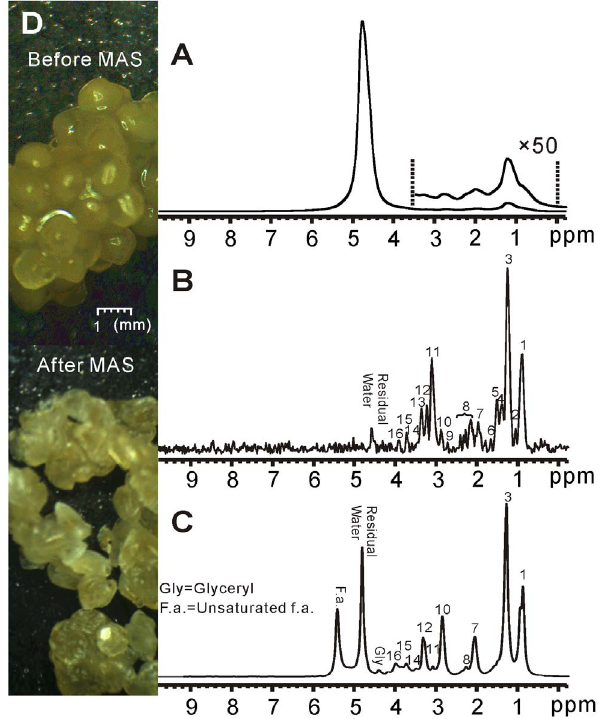
Figure 4. 1 H NMR spectra of shishamo smelt eggs. (A) Conventional 1D spectrum. (B) 1D iMQC spectrum. (C) 1D HR MAS spectrum. (D) Fifty-time magnified photos of eggs before and after